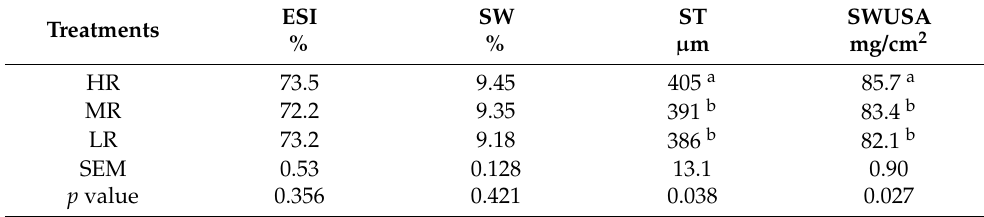
Table 3. Effect of ω -6/ ω -3 PUFA ratio on external egg quality traits of LSL laying hens. Treatments